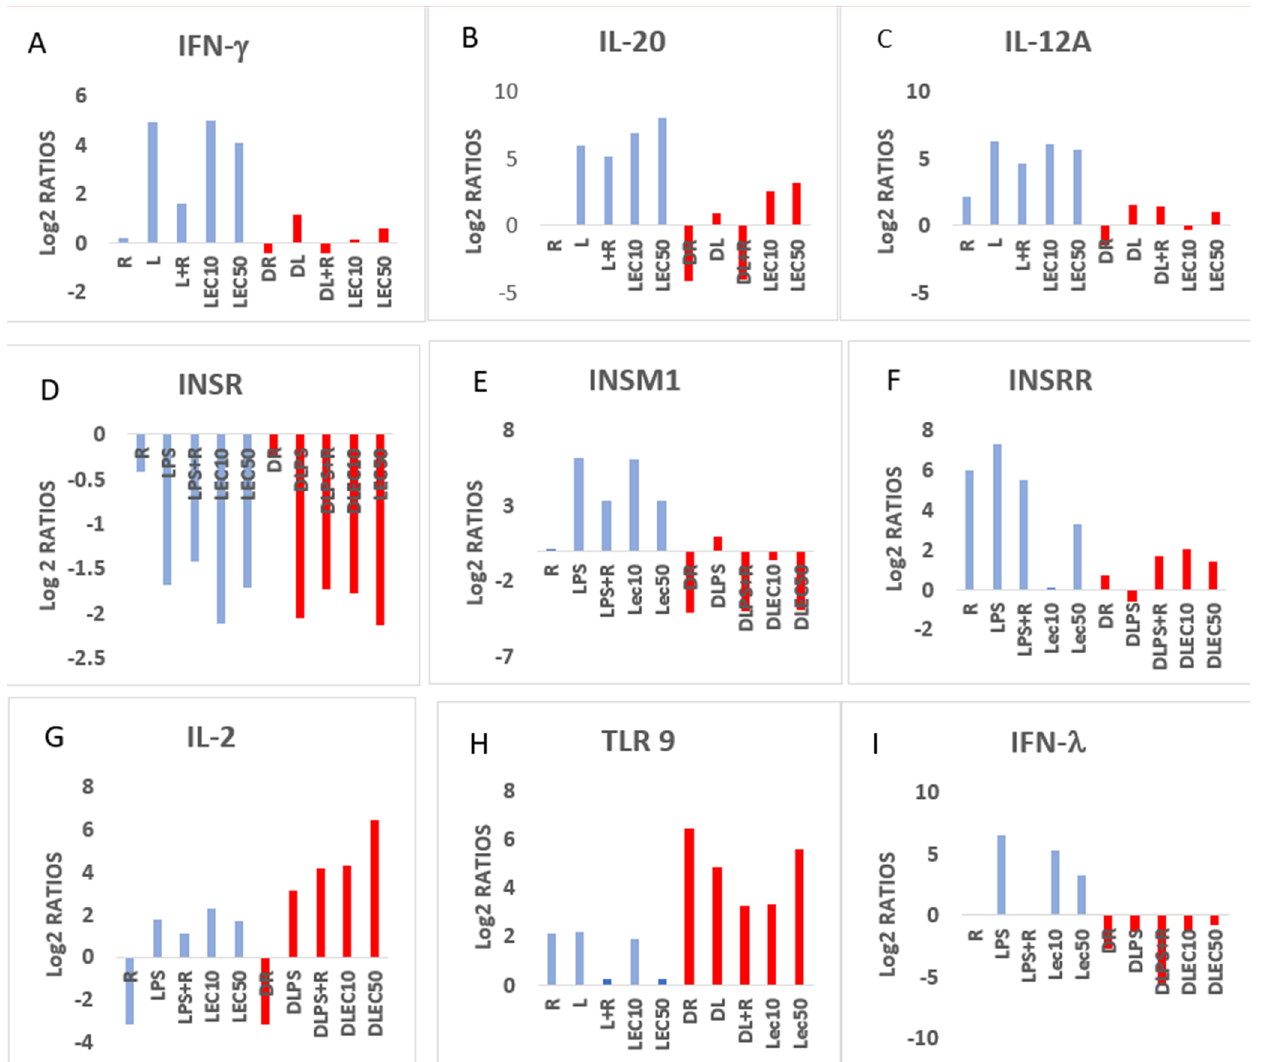
Figure 6. Cytokine and other inflammation-linked genes modulated by RES (R), LPS (L), LPS + RES (LPS + R, LR), LEC10 (lectin 10 μ g/mL) and LEC50 (lectin 50 μ g/mL) in PBMCs from non-diabetic controls (blue bars); and DRES (DR), DLPS (DL), DLPS + RES (DL + R), DLEC10 (lectin 10 μ g/mL) and DLEC50 (lectin 50 μ g/mL) in PBMCs from PwD2 (red bars). Cytokine genes are differentially regulated in PBMCs of non-diabetic controls and PwD2. ( A ). IFN- γ , ( B ). IL-20, ( C ). IL-12A, ( D ). INSR, ( E ). INSM1, ( F ). INSRR, ( G ). IL-2, ( H ). TLR9, and ( I ). IFN- λ.